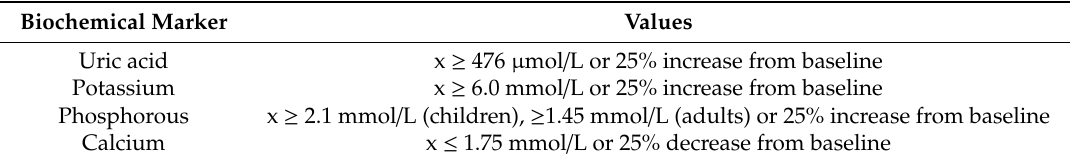
Table 2. Cairo and Bishop laboratory criteria for tumor lysis syndrome (TLS) (laboratory tumor lysis syndrome, LTLS).